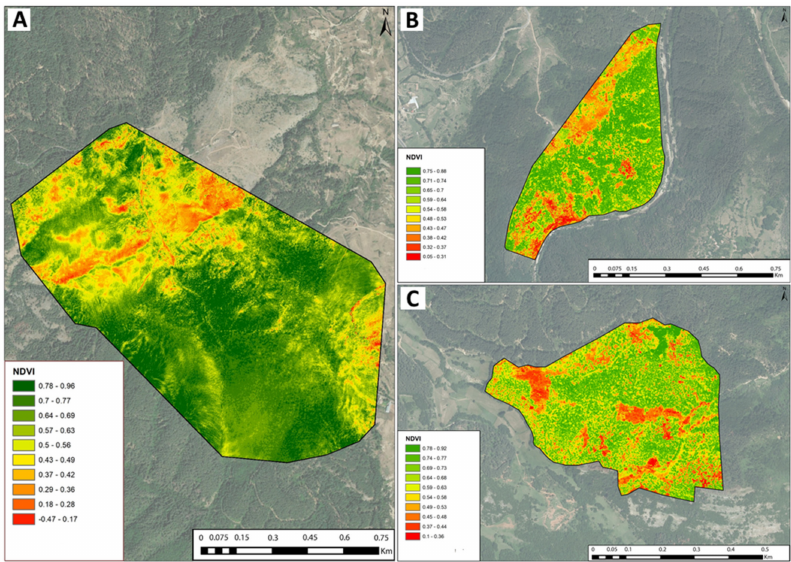
Figure 2. NDVI models of captured areas: ( A ) Fotinovo; ( B ) Kirkovo; ( C ) Kremen.